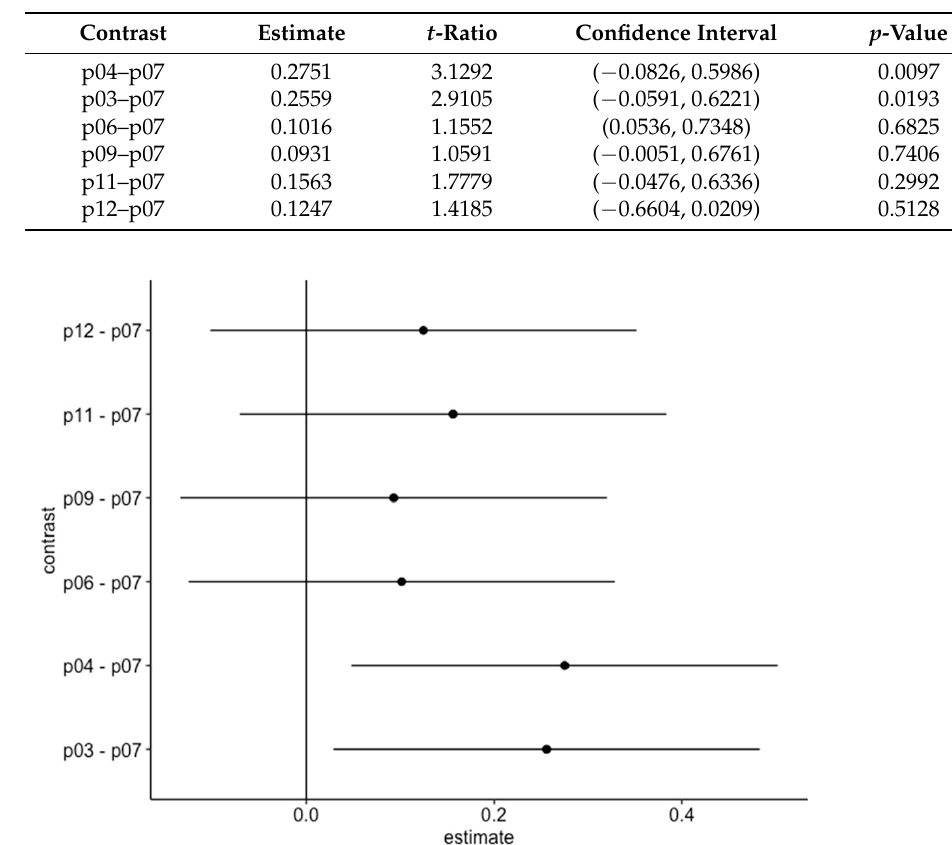
Figure 14. 95% confidence interval of mean difference between Agrivoltaic plots and non- Figure 14. 95% con fi dence interval of mean di ff erence between Agrivoltaic plots and non-Agri- Agrivoltaic voltaic plot.